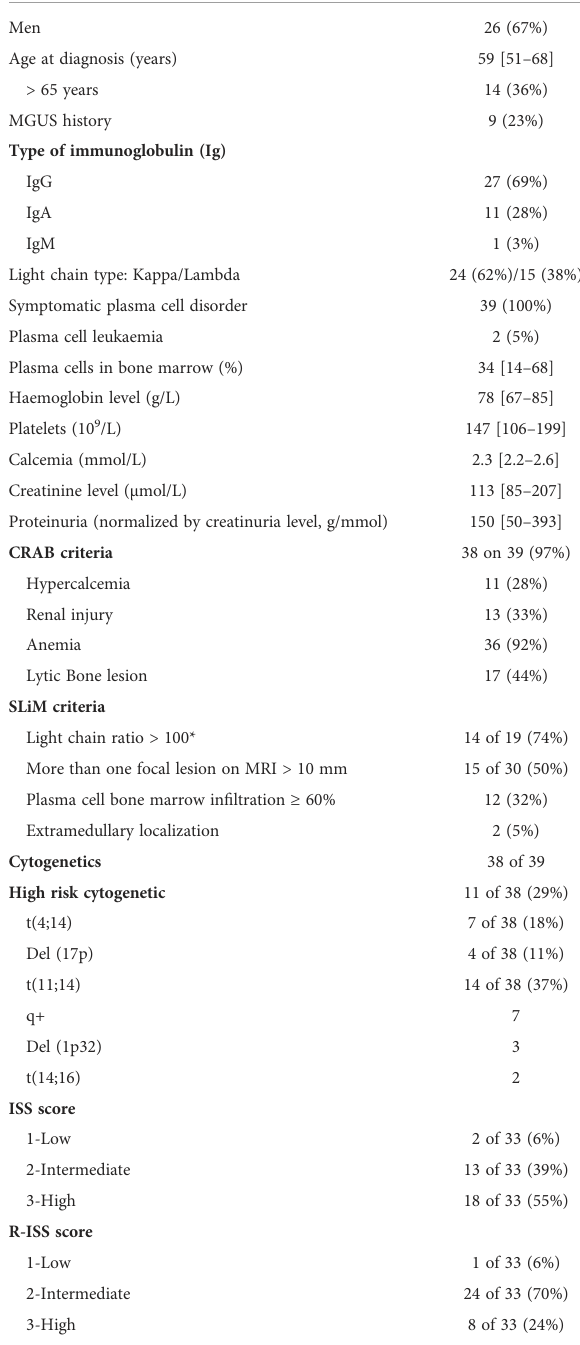
TABLE 1 Initial characteristics of NDMM with